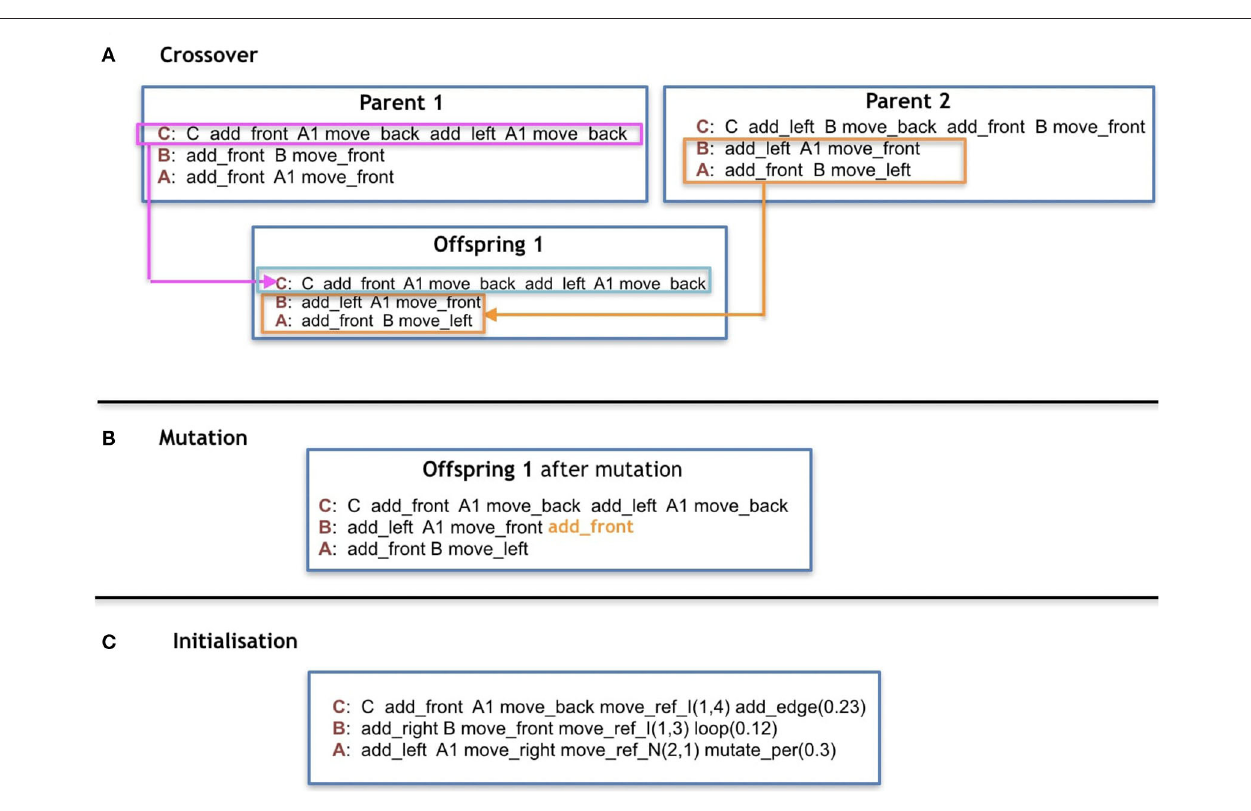
FIGURE 7 | (A,B) Are examples of reproduction operators, and (C) is an example of initialization using only 1 group of symbols for all cases of